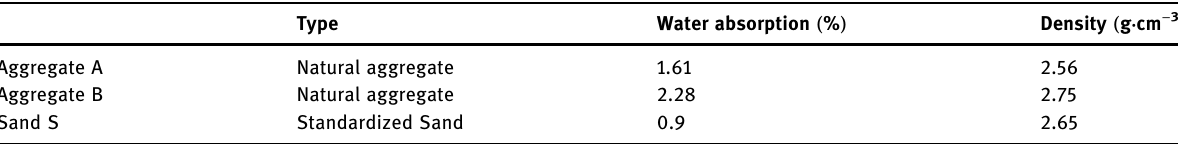
Table 1: Physical properties of the aggregates A, B and the sand S used as